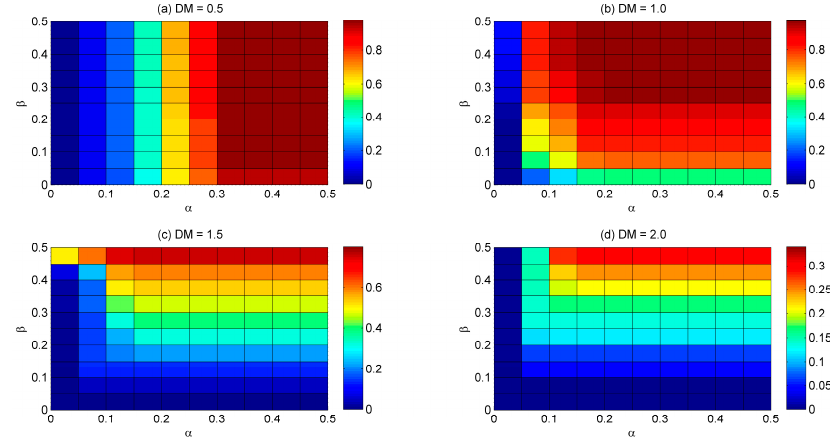
Figure 2 . The evolution process of system reliability with different DM conditions: ( a ) DM = 0.5; ( b ) DM = 1.0; ( c ) DM = 1.5; ( d ) DM = 2.0.